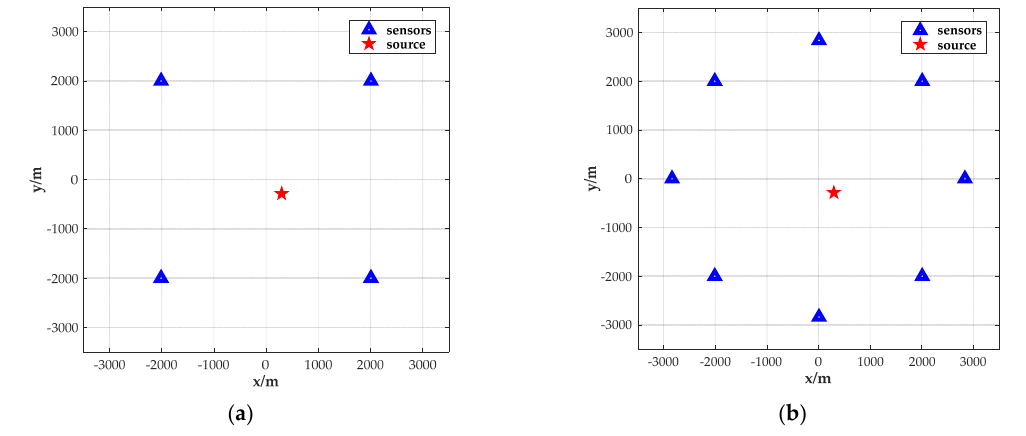
Figure 7. Positions of the sensors and source used in the simulation with the source position located at ( 300, − 280 ) m. ( a ) Positions of four sensors and a source; ( b ) positions of eight sensors and a